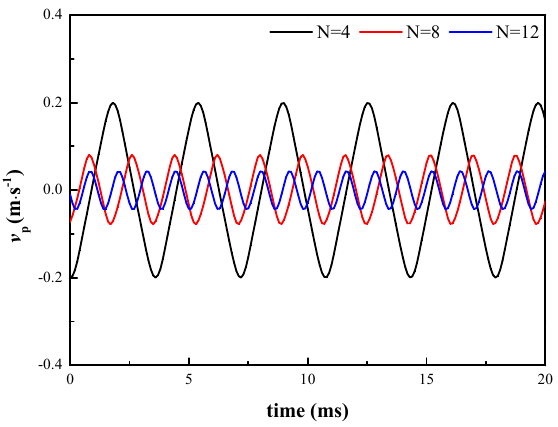
Figure 17. Displacements of different orifice numbers.